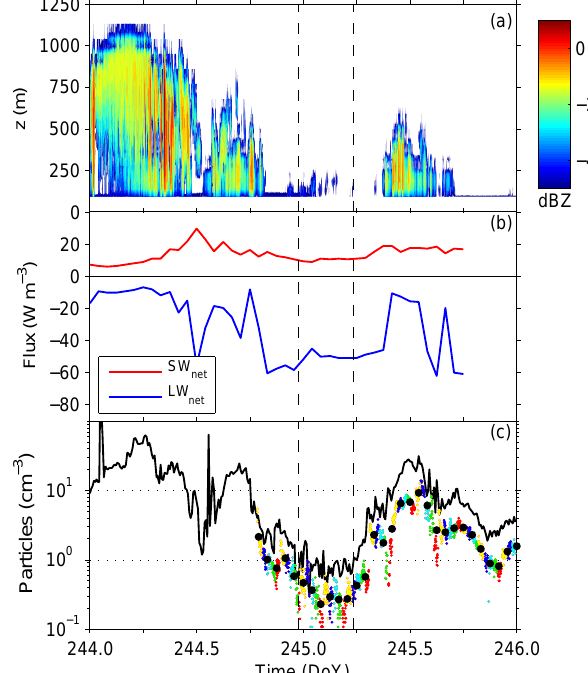
Fig. 8. Cloud and aerosol observations from the 5th regime (a) radar reflectivity, (b) observed net shortwave and long- wave radiative fluxes and (c) accumulation mode particle (60nm < diameter < 800nm) concentration from the DMPS (black line) and mean CCN concentration (black dots), computed from measurements made at a range of supersaturations (coloured dots, red 0.11%, green 0.16%, cyan 0.21%, blue 0.42% and yellow 0.73%). The vertical dashed lines show the times of the two ra- diosondes used in the SCM runs in Figs. 9–11.